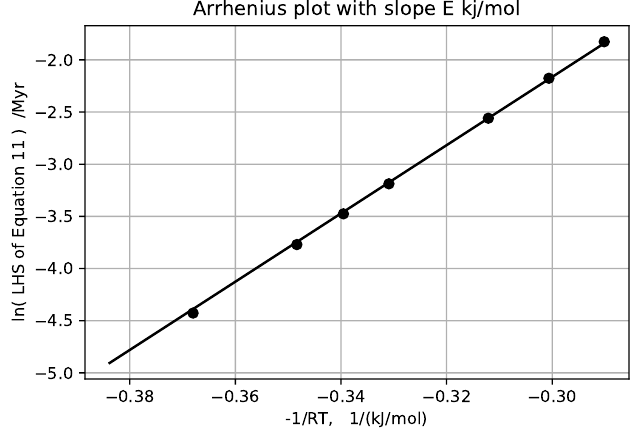
Figure 23. Oklahoma − 1/RT.